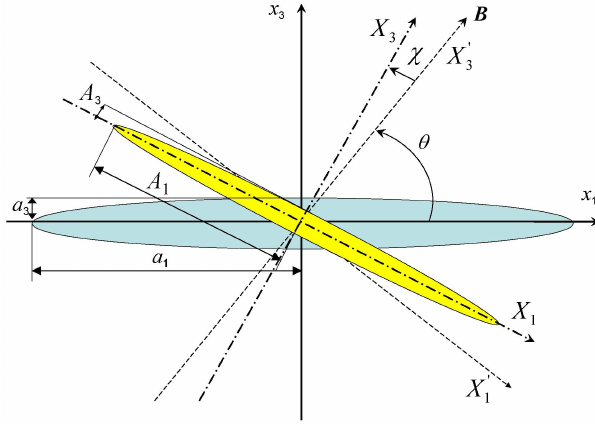
Fig. 1. Schematic of the elongated ellipsoidal trail and successive coordinate transformations x i → X 0 j → X k (described in detail in Appendix A). Only the common magnetic field–trail axis plane is shown. The original trail is shaded blue; θ is the angle between x 1 and B ;axis X 0 3 is along B . Rescaled along B by the small factor of (cid:15) , Eq. (6), the trail is shaded yellow; χ is the angle between X 0 3 and X 3 ; the final axes X k are aligned with the principal axes of the rescaled ellipsoid; a k and A k are the semi-axes of the original and rescaled ellipsoids, respectively.